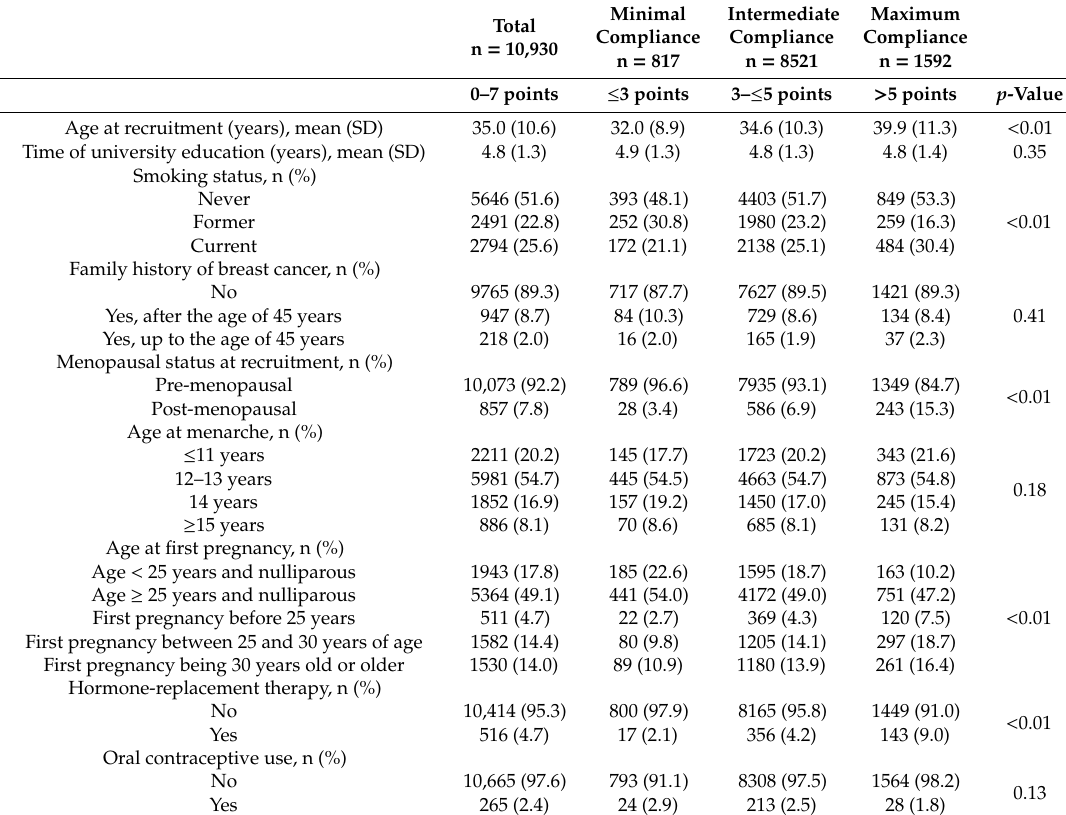
Table 1. Baseline characteristics of the female participants in the SUN Project for the overall sample and according to categories of adherence to the 2018 WCRF / AICR